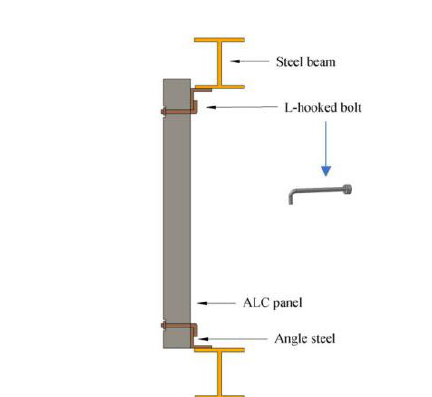
Figure 3. Detail of connectors. ( a ) L-hooked bolt. ( b ) Upper node. ( c ) Lower node.